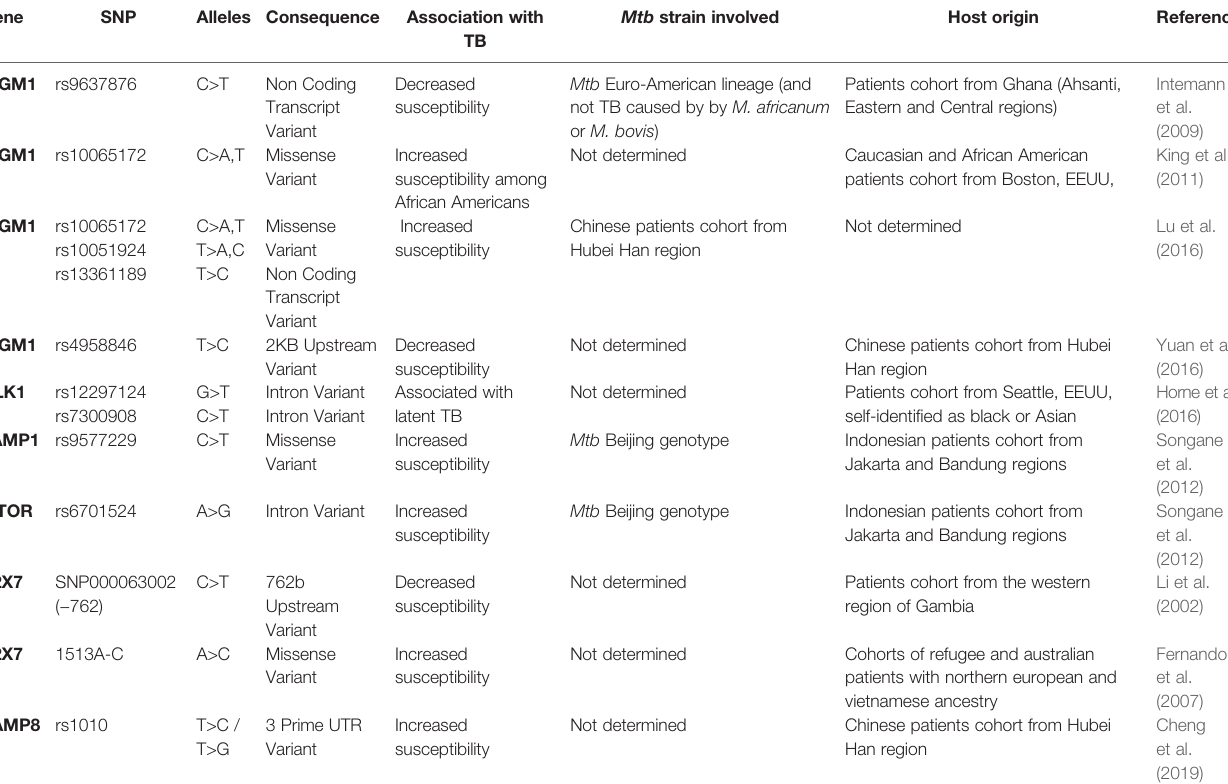
TABLE 3 | SNPs in autophagy-related genes associated with TB. List of SNPs in genes codifying for proteins involved in autophagy that have been found to be associated with increasing or decreasing susceptibility to active TB. Gene